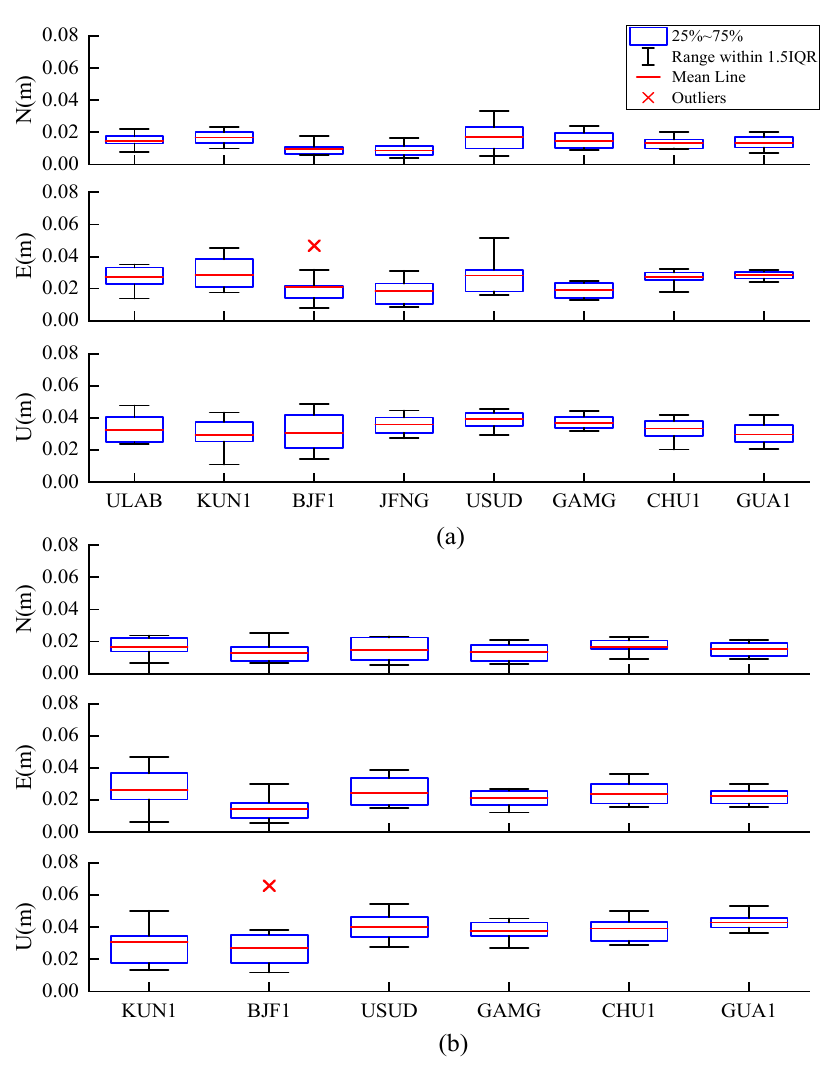
Figure 7. ( a ) Static position errors RMS using PPP-B2b BDS B1I/B3I + GPS; ( b ) static position errors RMS using PPP-B2b BDS B1C/B2a + GPS. Table 6. Mean RMS values of PPP-B2b static positioning of each station using B1I/B3I.